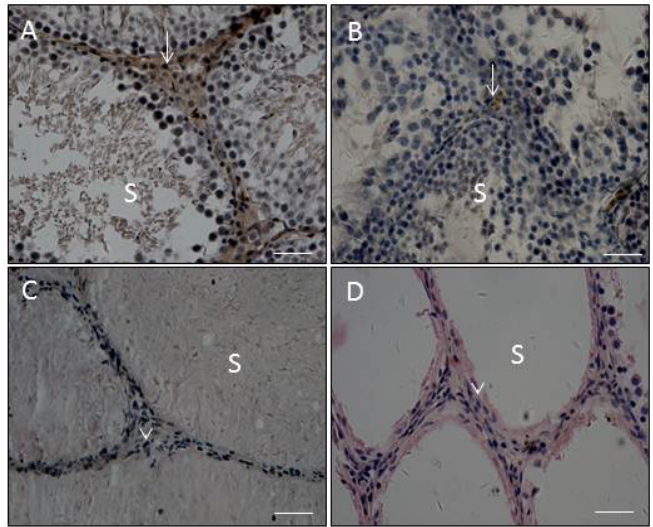
Figure 2. Immunohistochemical staining of 58-day-post-EDS rat testis sections from estradiol (E2) or methoxychlor (MXC). ( A ) Control group; ( B ) E2 group; ( C ) 10 mg/kg of MXC group; ( D ) 100 mg/kg of MXC group. Brown cytosolic staining was 11 β -hydroxysteroid dehydrogenase 1, the biomarker of more mature Leydig cells. White arrows point to the Leydig cells. White arrowheads point to the unstaining spindle-shaped cell. S, seminiferous tubules. Bar = 50 µm.